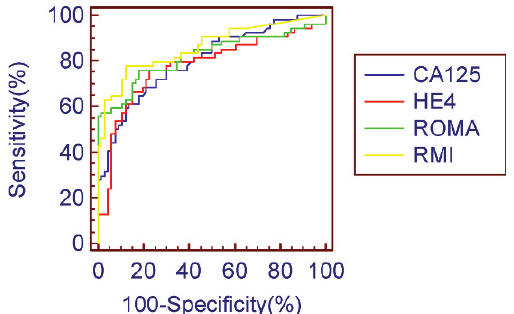
Figure 1 - The Receiver Operating Characteristic (ROC) curves for CA125, HE4, ROMA, and RMI in this